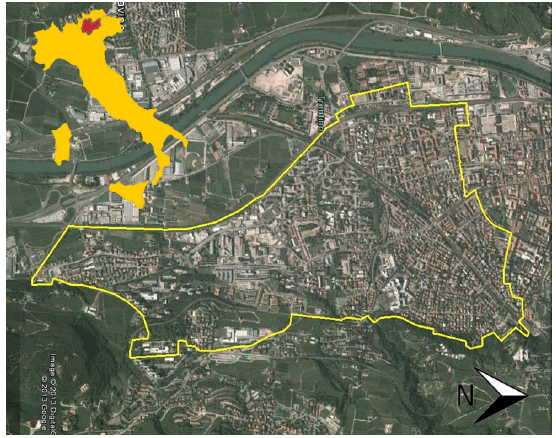
Figure 1 Position of the city of Trento in Italy with the extents of the study area (Image source: Google